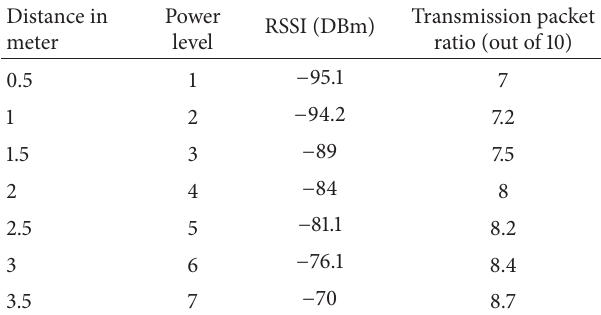
Figure 6: Packet transmission ratio at different power